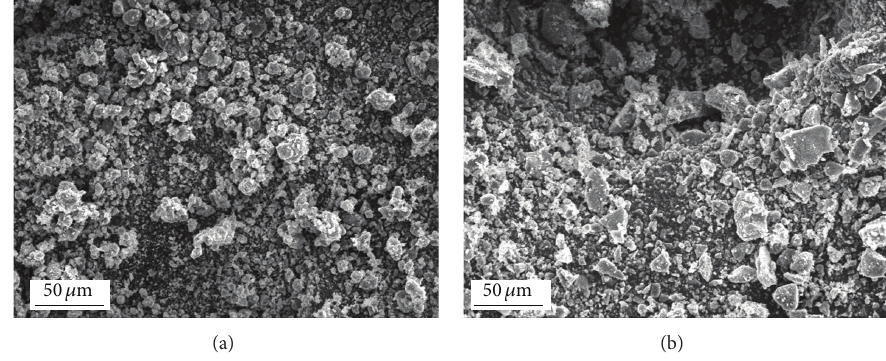
Figure 5: SEM images of the mesoporous anatase phases (a) SR4 (b)